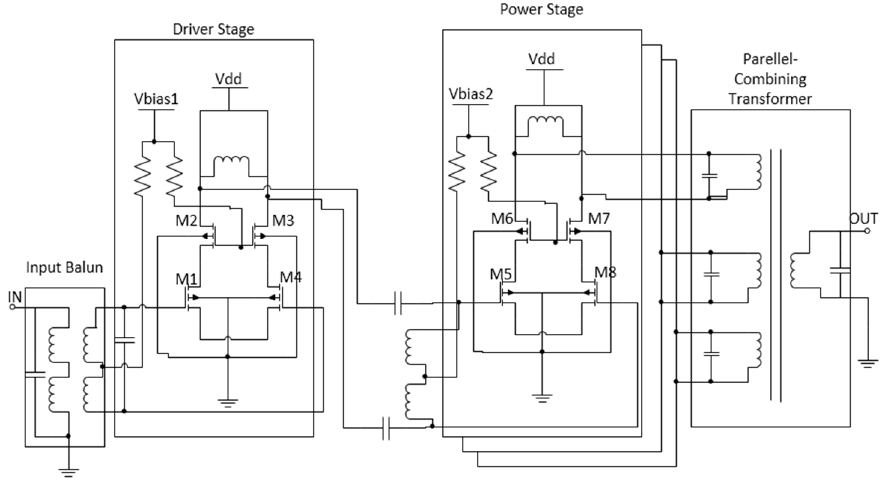
Figure 14. Proposed differential class-AB PA with parallel combining transformer (PCT) [46].